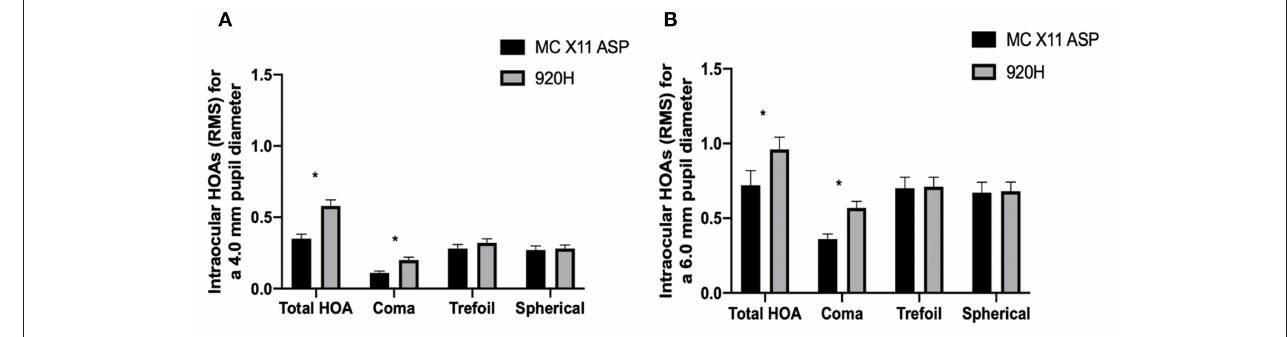
FIGURE 2 | Intraocular high-order aberrations of Group A and Group B at 3 years after surgery. Between-group differences for intraocular aberrations at 4mm (A) and 6mm (B) pupil diameters. * P < 0.05. HOAs, higher-order aberrations; RMS, root mean square. Error bars represent the SEM.